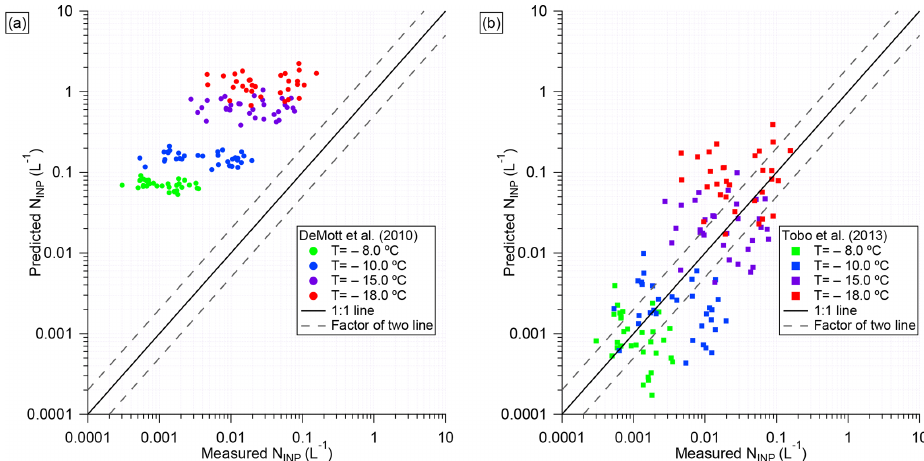
Figure 5. Scatter plot of measured N INP against predicted N INP obtained from parameterizations by (a) DeMott et al. (2010) and (b) Tobo et al.